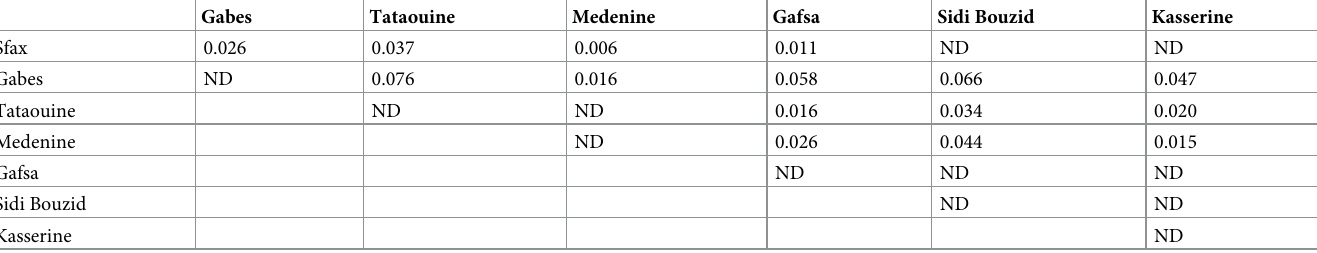
Table 3. Genetic differentiation ( F st index) between M . bovis populations of the different governorates. Gabes